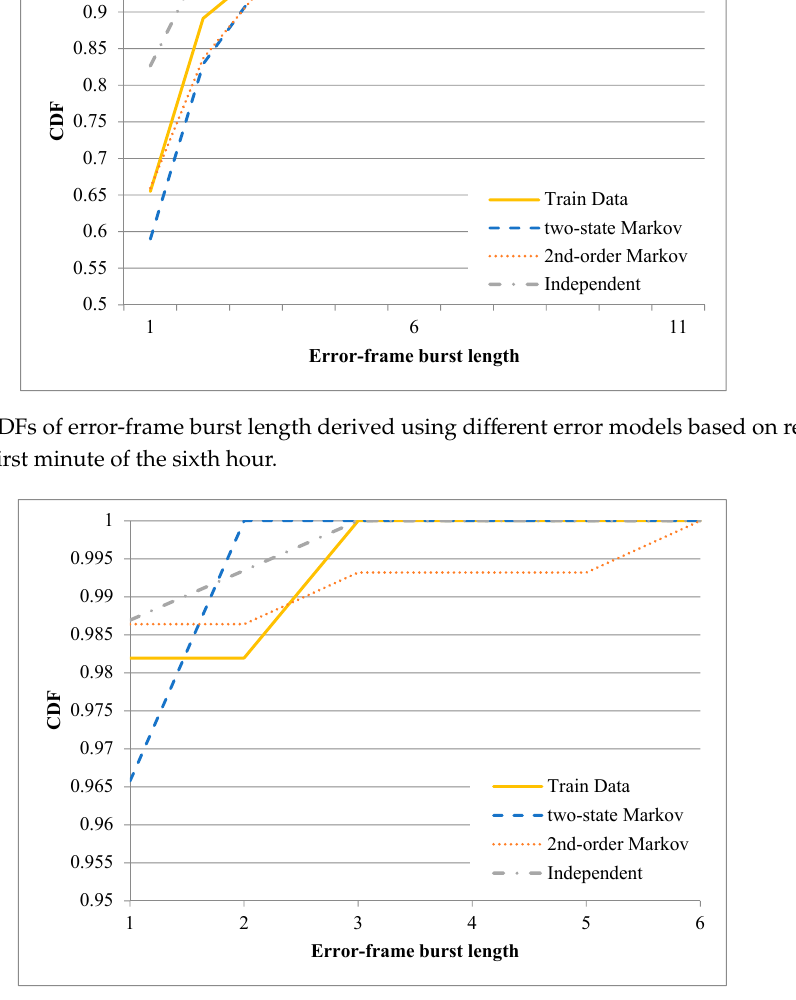
Figure 14. CDFs of error-frame burst length derived using different error models based on recorded trace in the first minute of the tenth hour.